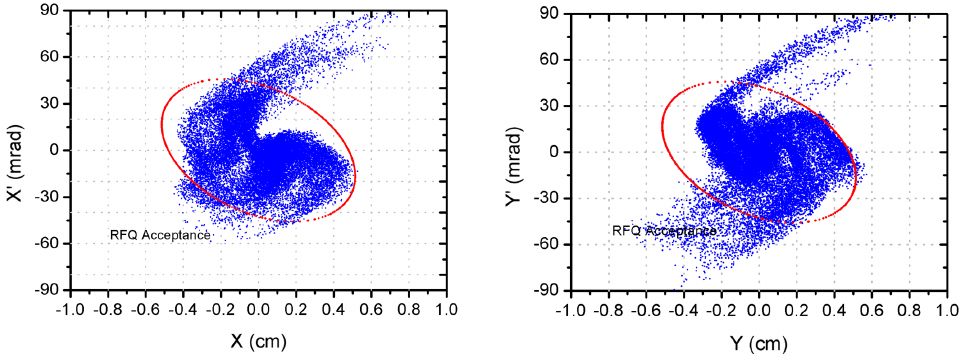
FIG. 19. Particle distributions in the phase spaces at the RFQ entrance without collimation.